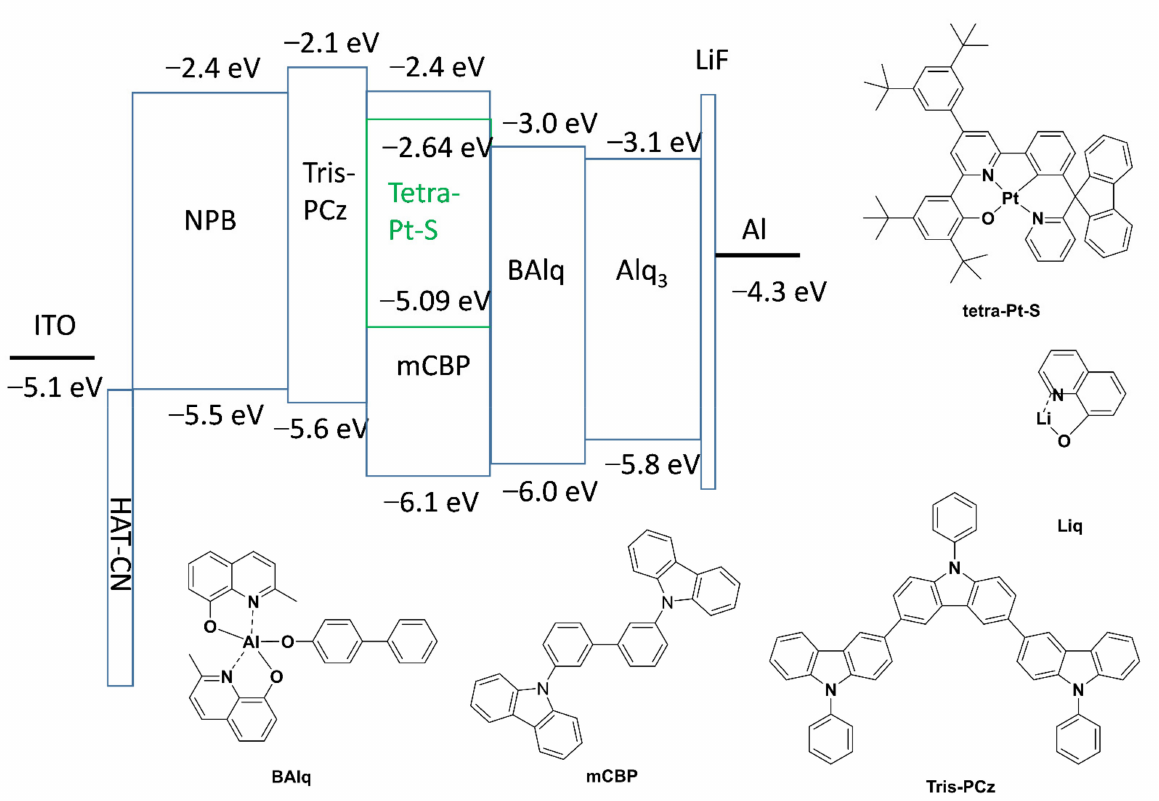
Figure 1. Proposed energy-level diagram of emitting dopant, host and transporting materials; chemical structures of bis(8-hydroxy-2-methylquinoline)-(4-phenylphenoxy)aluminum (BAlq), 3,3-di(9H-carbazol-9-yl)biphenyl (mCBP), 9,9 (cid:48) ,9 (cid:48)(cid:48) - triphenyl-9H,9 (cid:48) H,9 (cid:48) H-3,3 (cid:48) :6 (cid:48) ,3 (cid:48) -tercarbazole (Tris-PCz), Liq, and